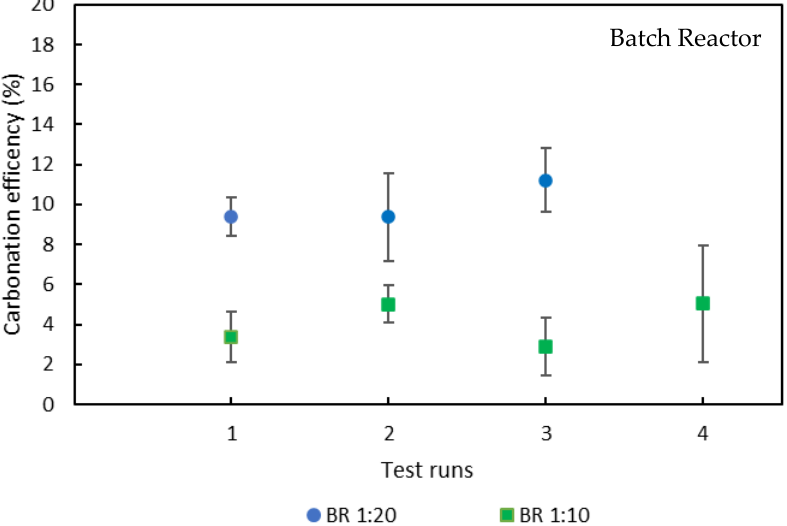
Figure 2. Carbonation efficiency for wood ash in a batch reactor (BR). Mean values ± standard deviations ( n = 4). Ash to water mixing ratios 1:20 (blue circles) and 1:10 (green squares). The fourth run of BR 1:20 was discarded because the analysis results were not plausible.